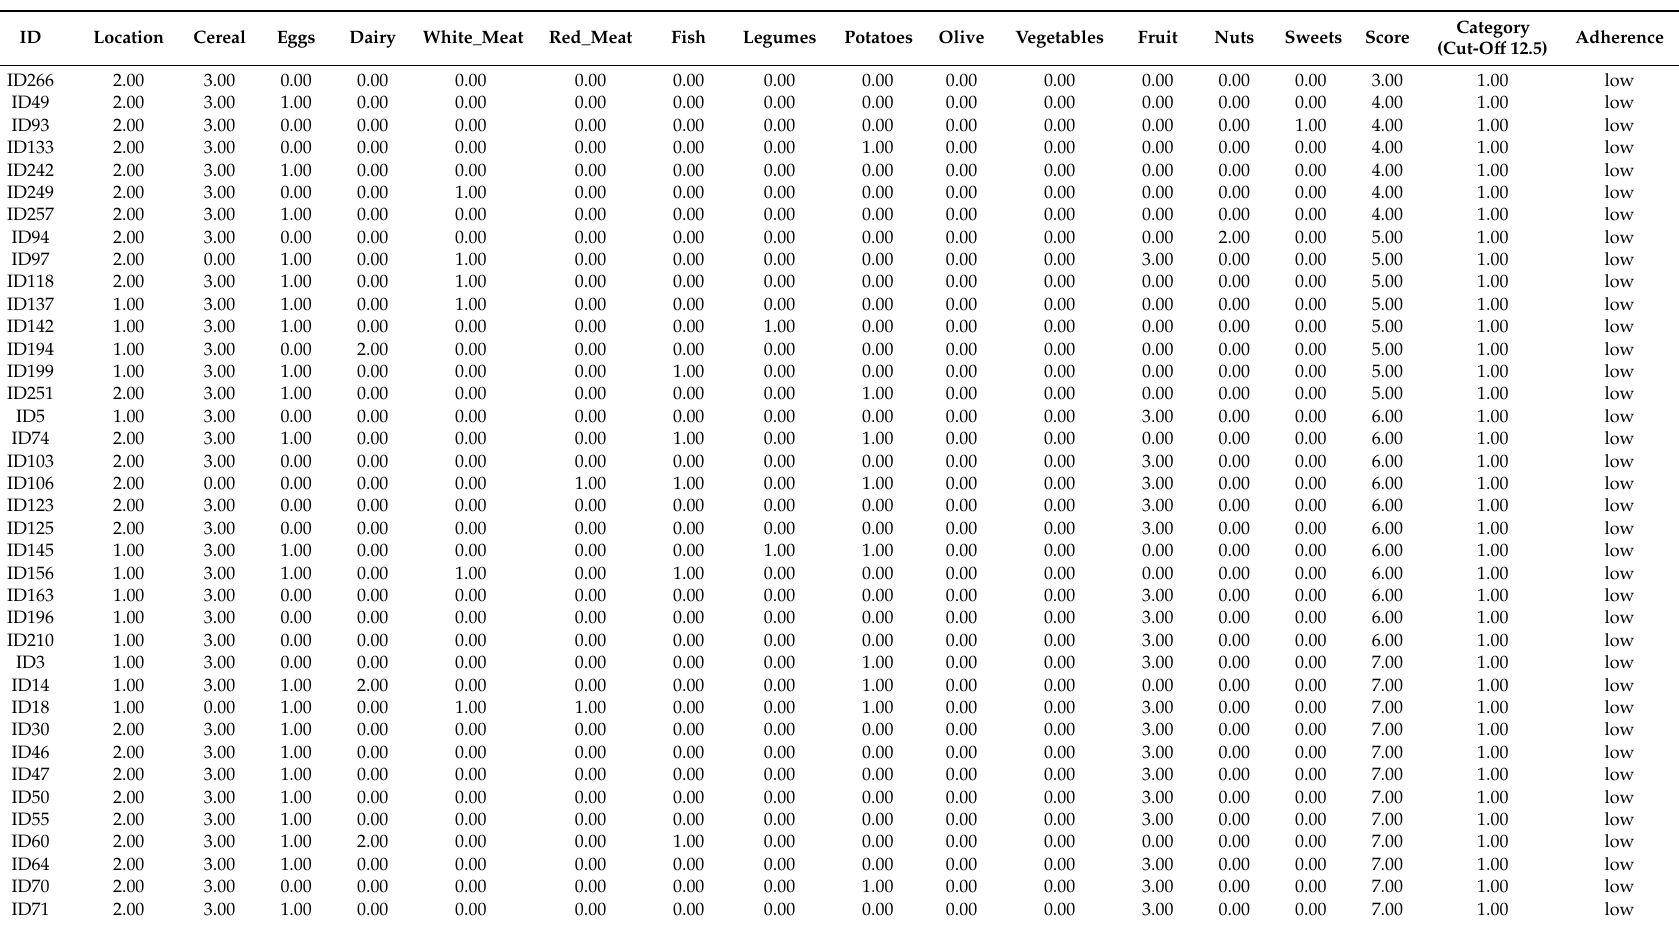
Table A1. MDSS score calculation according to specific food